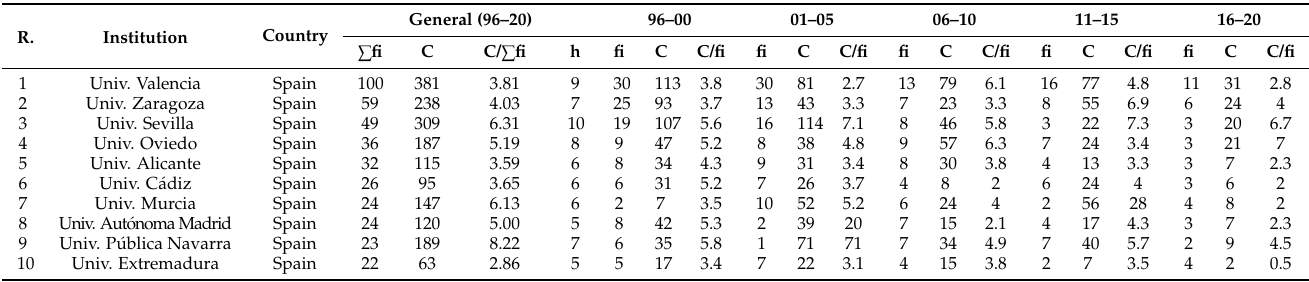
Table 8. Most productive University Institutions in